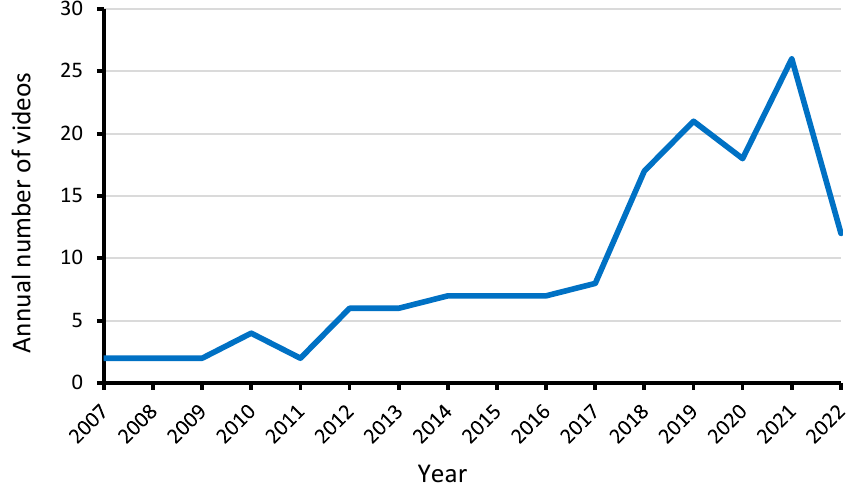
Figure 2. Frequency count of videos uploaded on YouTube from 2007 to 2022.